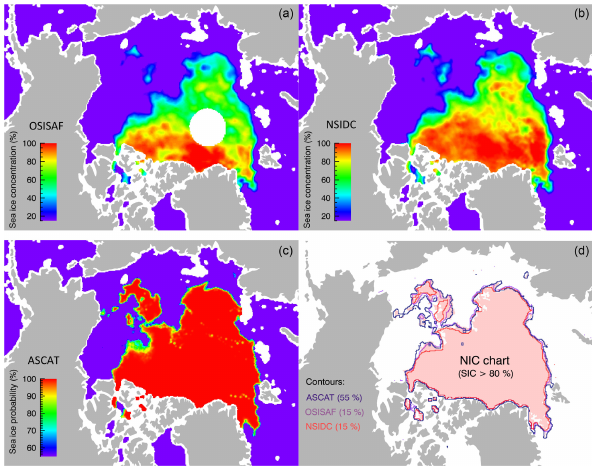
Figure 7. Comparison of summer sea ice extents on 15 Septem- ber 2016 from passive microwaves (NSIDC-0051 a , OSI SAF-430 b ), active microwaves (ASCAT, c ) and NIC sea ice charts (d) . The color scales represent sea ice concentration ( a, b , lower limit 15%), sea ice probability ( c , lower limit 55%) and NIC sea ice concentra- tion larger than